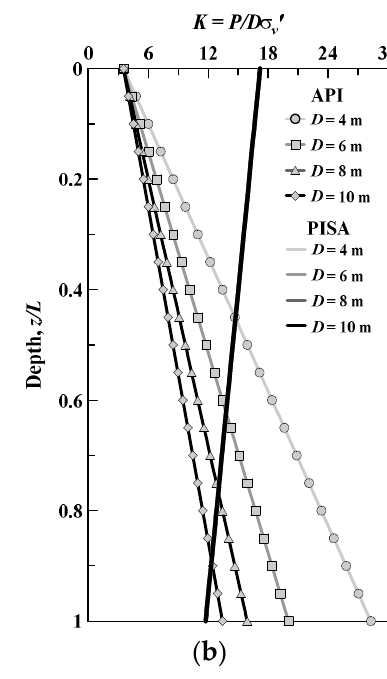
Figure 2. Normalized ultimate soil resistance profile against: ( a ) z/D , ( b ) z/L.